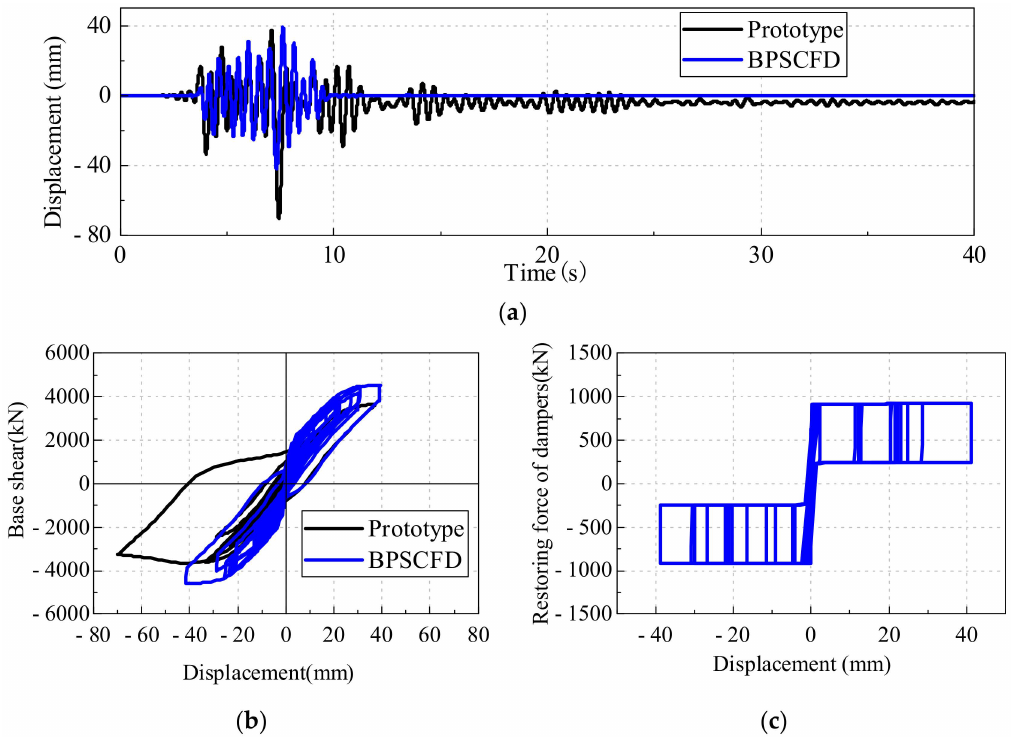
Figure 18. Responses of bridges under Coalinga-01 ground motion: ( a ) displacement time-history curves, ( b ) hysteretic curves of bridge bent, ( c ) hysteretic curve of